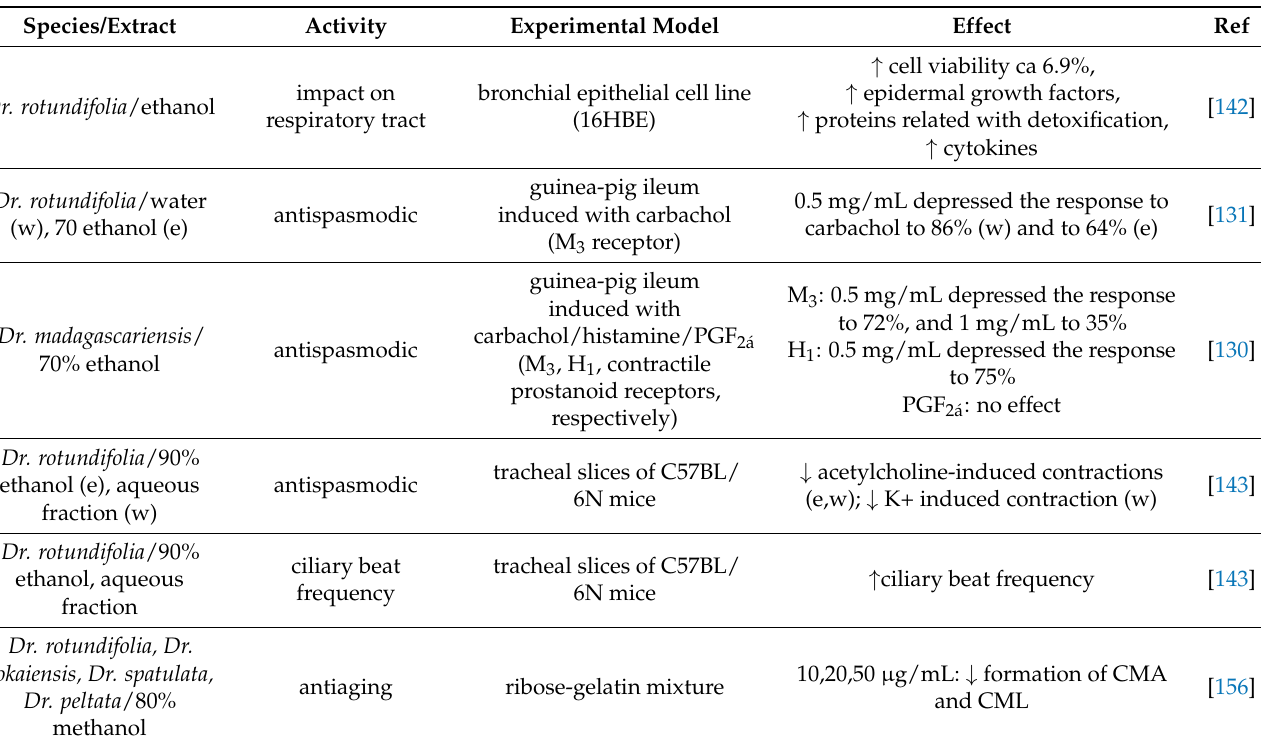
Table 6. Other types of activity of carnivorous Nepenthales